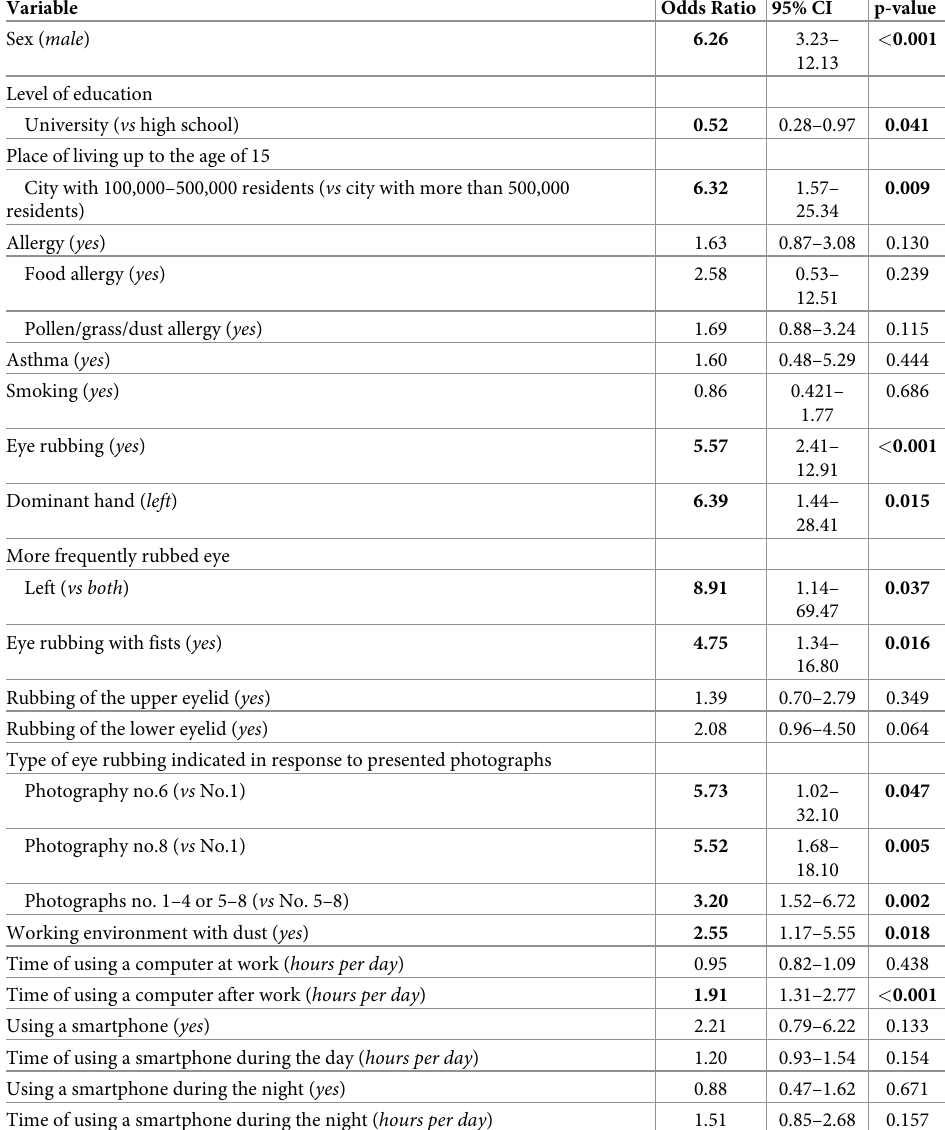
Table 4. Selected results of the risk analysis of behavioral, environmental and socioeconomic factors in KTCN. For each variable, the odds ratio, 95% confidence interval (CI), and p-value are presented.